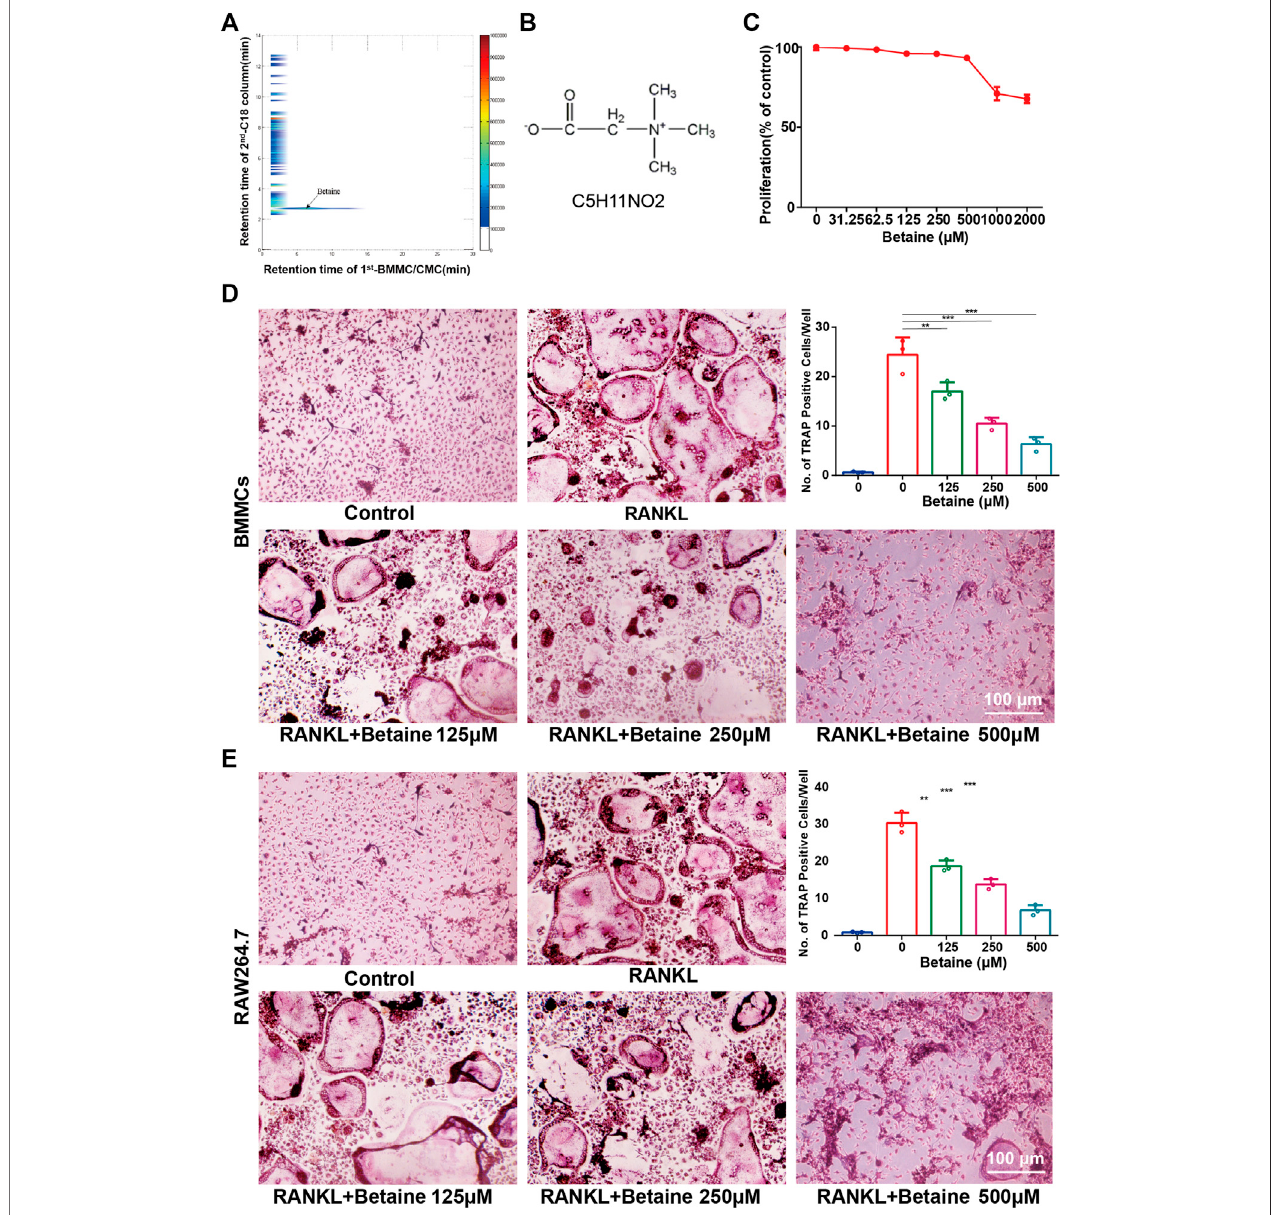
FIGURE 1 | Betaine suppresses osteoclastogenesis in vitro . (A) Typical 2D plots of Lycii Radicis Cortex (LRC) by 2D BMMC/CMC/C18 column/TOFMS assay system. (B) Chemical formula of betaine. (C) CCK-8 assay of betaine ’ s cytotoxicity in BMMCs. (D) Formation and quanti fi cation of tartrate-resistant acid phosphatase (TRAP)positiveosteoclastcellsfromBMMCs. (E) Formationandquanti fi cationofTRAPpositiveosteoclastcellsfromRAW264.7cells.* p < 0.05asdenotedbybar,** p < 0.01 as denoted by bar, *** p < 0.001 as denoted by bar.